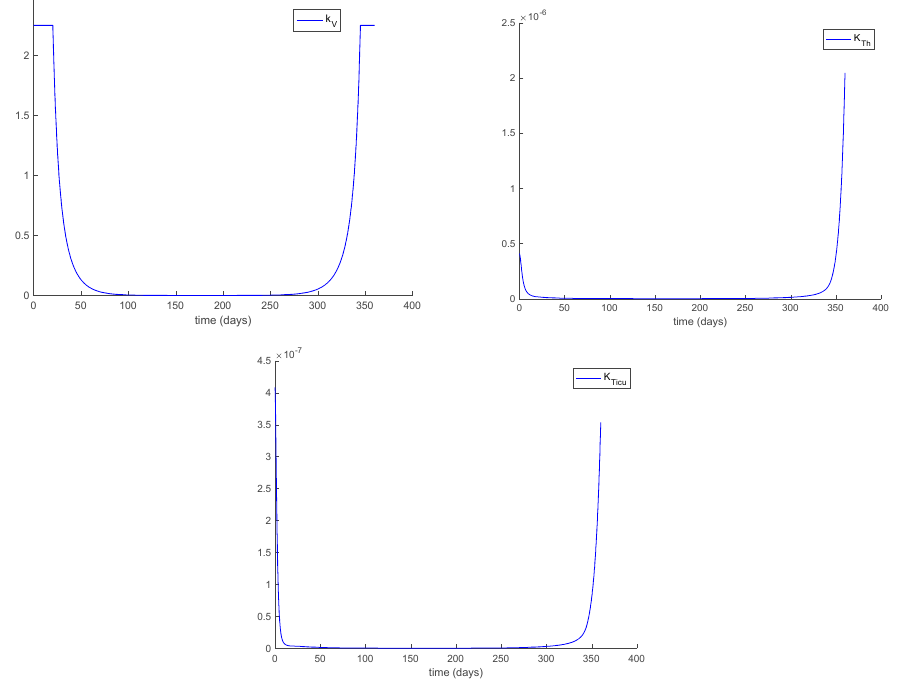
Figure 9. Control gains when Programme 6 is employed.